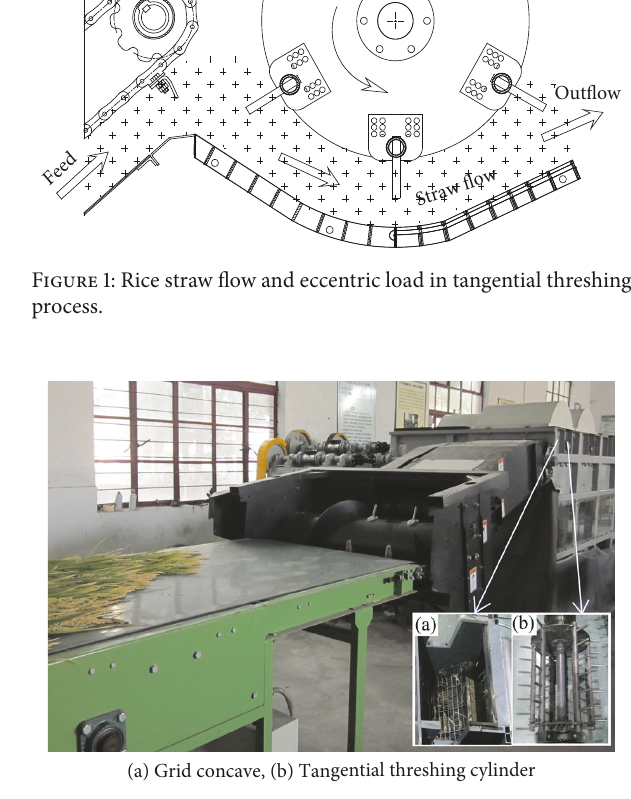
Figure 2: Tangential threshing cylinder test